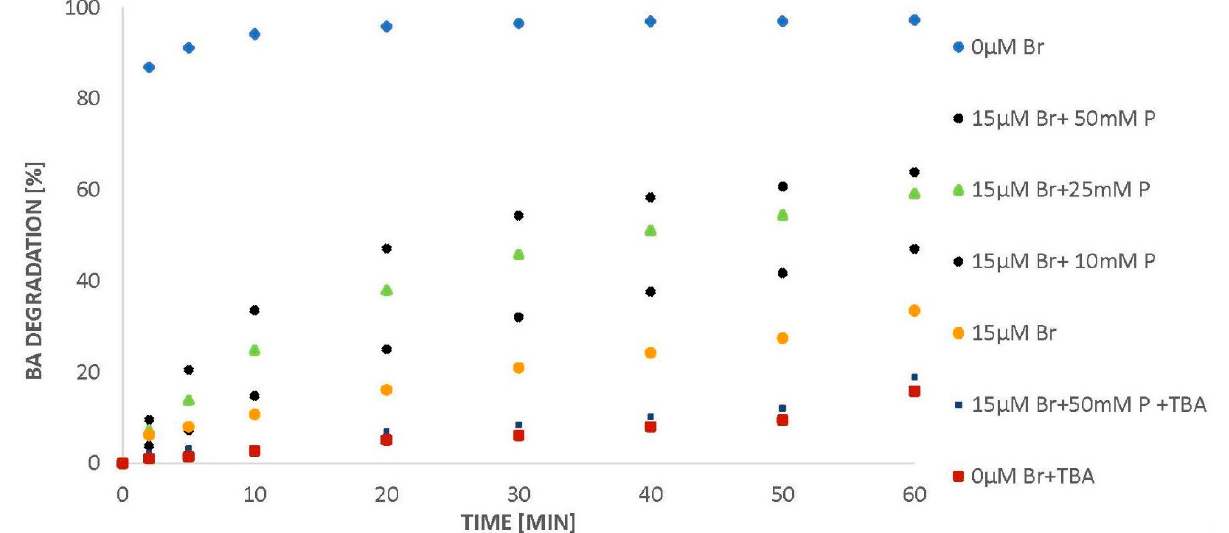
Figure 6. BA degradation (24 µM) in the presence of bromides (15 µM) and a variable amount of phosphates ( p = 0–50 mM), pH = 2.5.